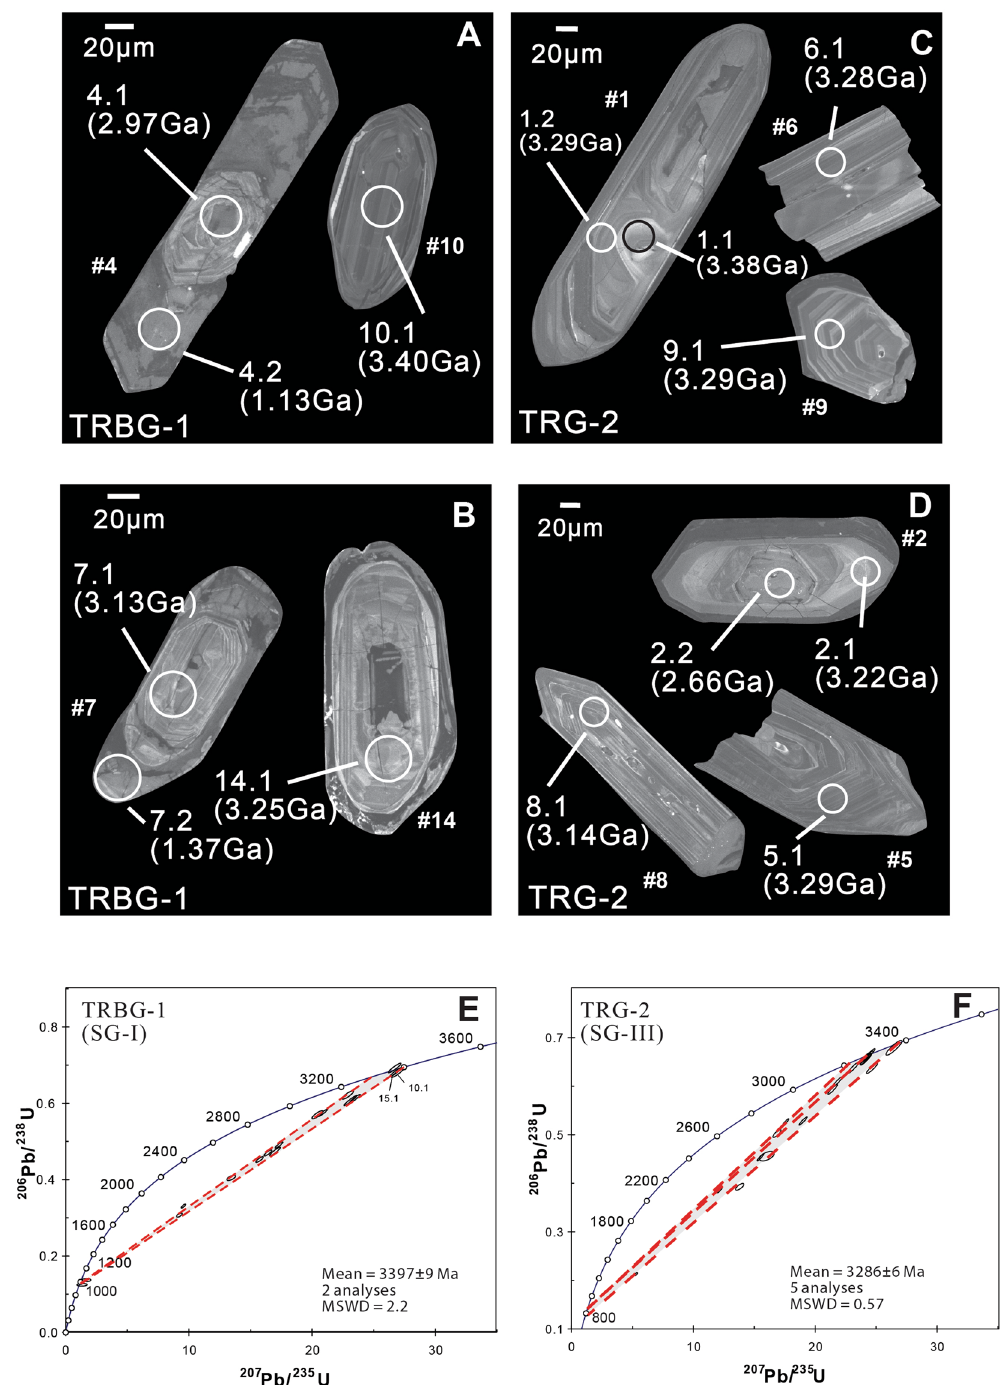
Figure 3. ( A , B ) Cathodoluminiscence (CL) image of zircons from Singhbhum granite sample TRBG-1 (SG- I), ( C , D ) from sample TRG-2 (SG-III). ( E , F ) U-Pb Concordia plots for the zircons from TRBG-1 and TRG-2 respectively (ages represent weighted mean of ages in Ma). Error ellipses are shown at 1 σ